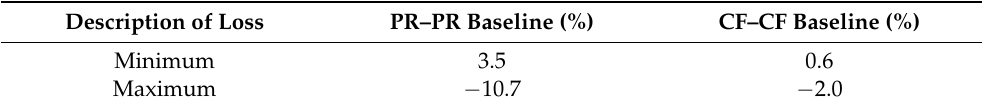
Table 6. Differences in performance ratio and capacity factor of the maximum and minimum cumulative effect of the site-related derate factors compared with the baseline for a 50 MW system.